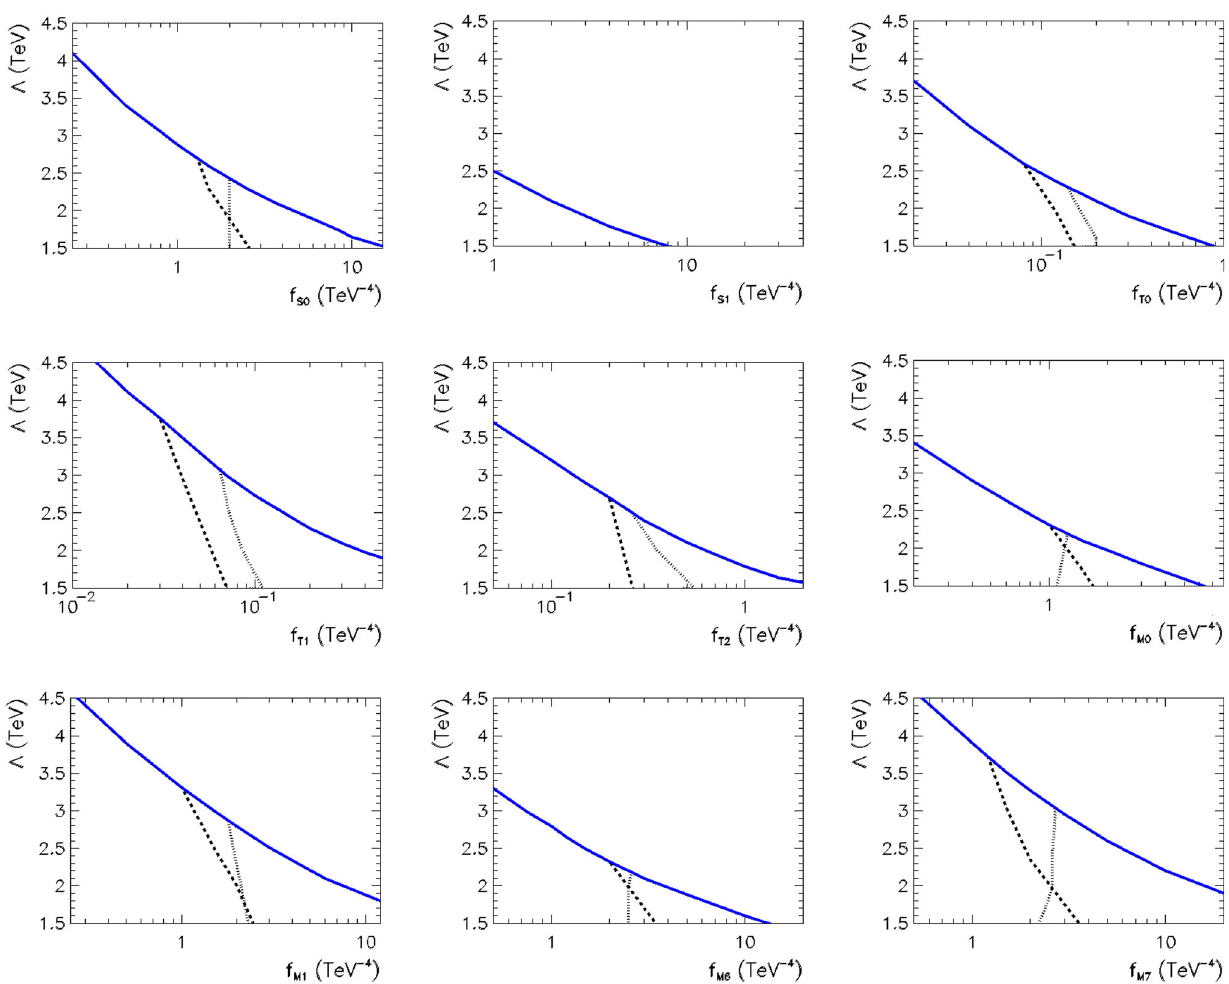
Fig. 4 Regions in the (cid:3) vs f (positive f values) space for dimension- 8 operators in which a 5 σ BSM signal can be observed and the EFT is applicable. The unitarity limit is shown in blue. Also shown are the